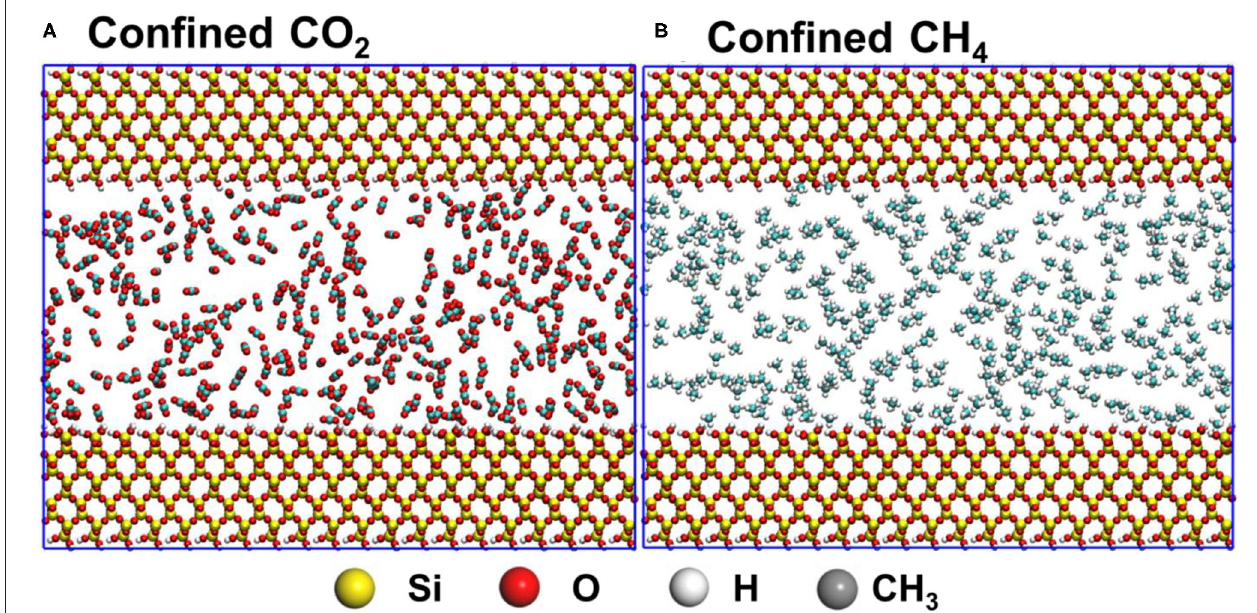
FIGURE 1 | The initial configurations of confined CO 2 and CH 4 in silica pores with diameters 4nm are shown in panels (A,B), respectively. Atoms in silica pores and confined gases molecules shown in CPK and VDW drawing methods, respectively, are implemented in VMD